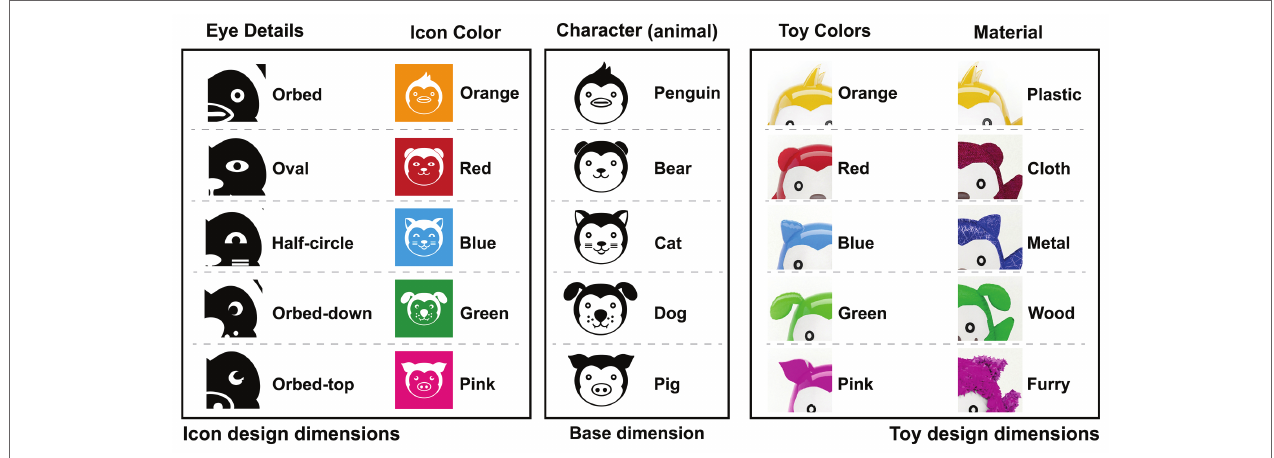
FIGURE 1 | Stimuli dimensions for icons and toys design.